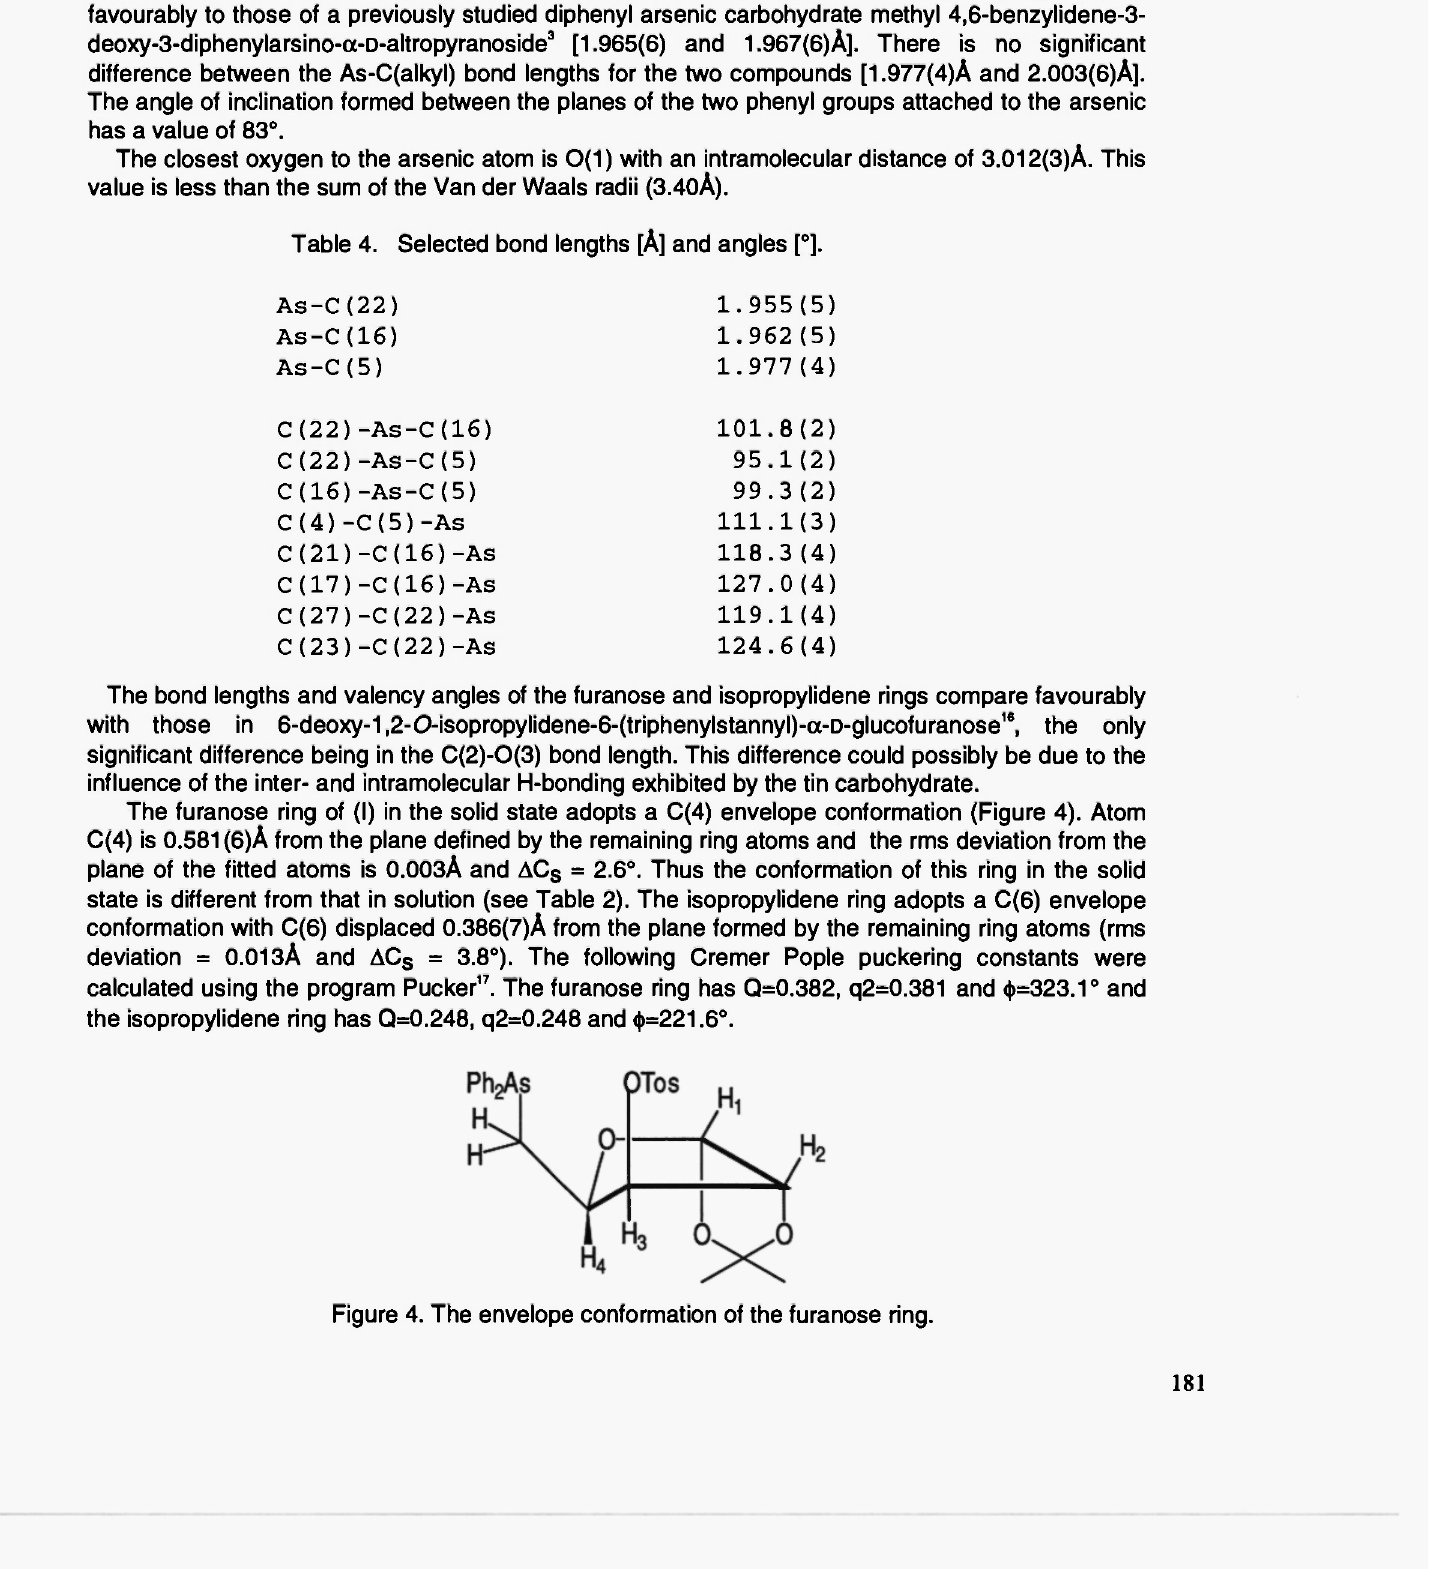
Table 4. Selected bond lengths [A] and angles [°].